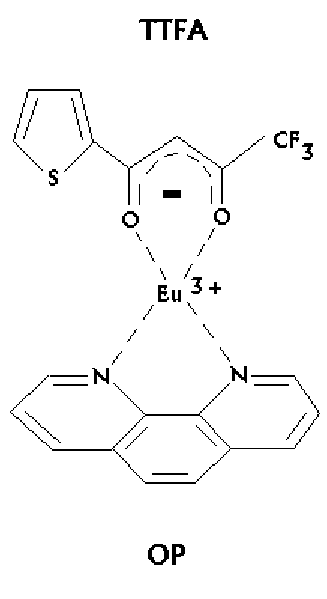
FIGURE 1. Binding of OP and TTFA to